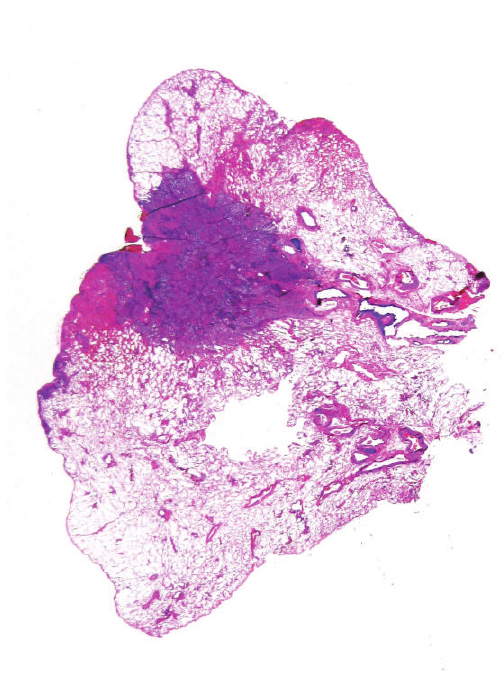
Figure 5: Lung cancer is easily staged using LS that evidence pleural invasion and distance from the bronchial